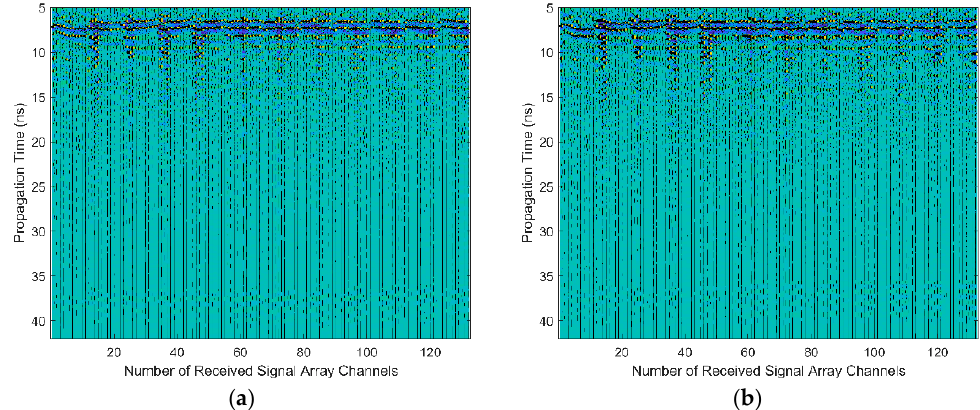
Figure 6. Two single-station laboratory original measured data based on the experiment model: ( a ) for Figure 5a, and ( b ) for Figure 5b, respectively.